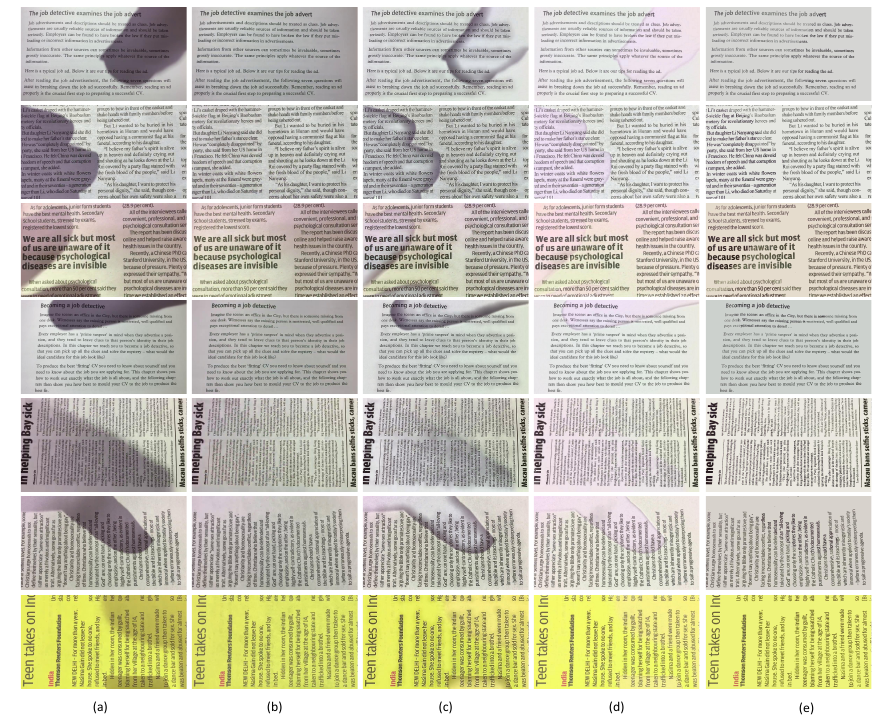
Figure 6. The visual comparisons of some state-of-the-art methods for the proposed OSR_CG dataset. ( a ) the input images, ( b ) the ground truth, ( c ) the results of [11], ( d ) the results of [24], ( e ) our results.